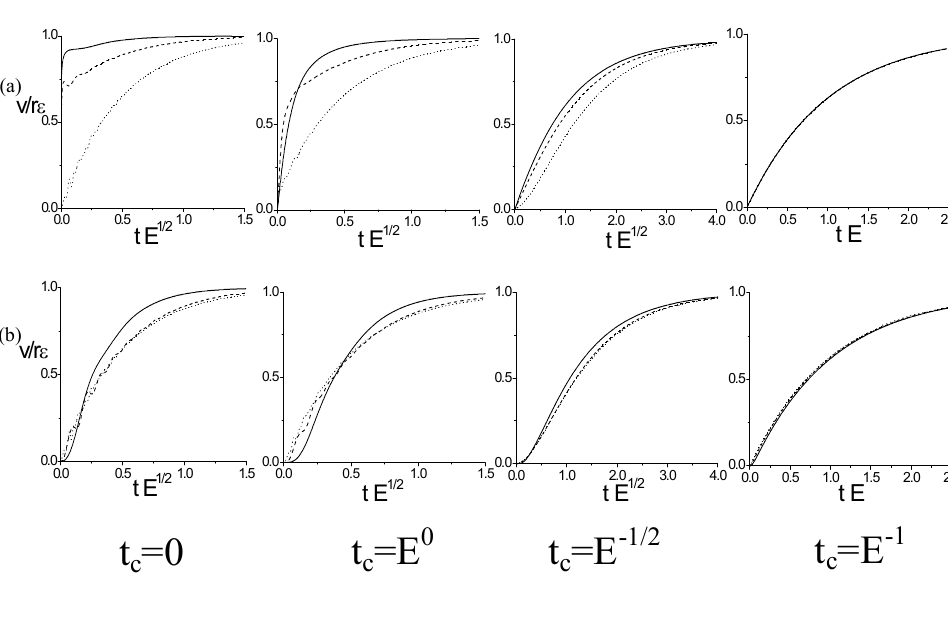
Fig 4. Effects of Ekman number on the evolution of azimuthal velocity, r=0.5. (a) in the Ekman layer (z=0.007) ; (b) in the interior (z=0.5). ,E=10 -2 ; , E=10 -3 ; , E=10 -4